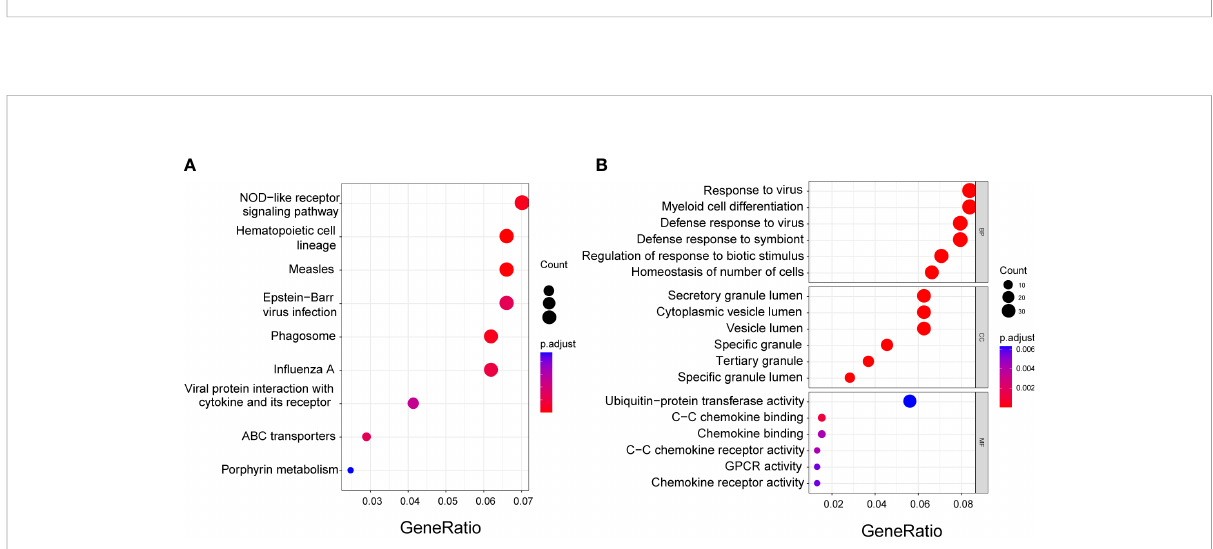
FIGURE 6 Functional enrichment analysis of the DEGs between low- and high-risk groups. (A) Kyoto Encyclopedia of Genes and Genomes (KEGG) analysis. (B) Gene Ontology (GO) enrichment analysis. BP, Biological process; CC, Cellular component; MF, Molecular